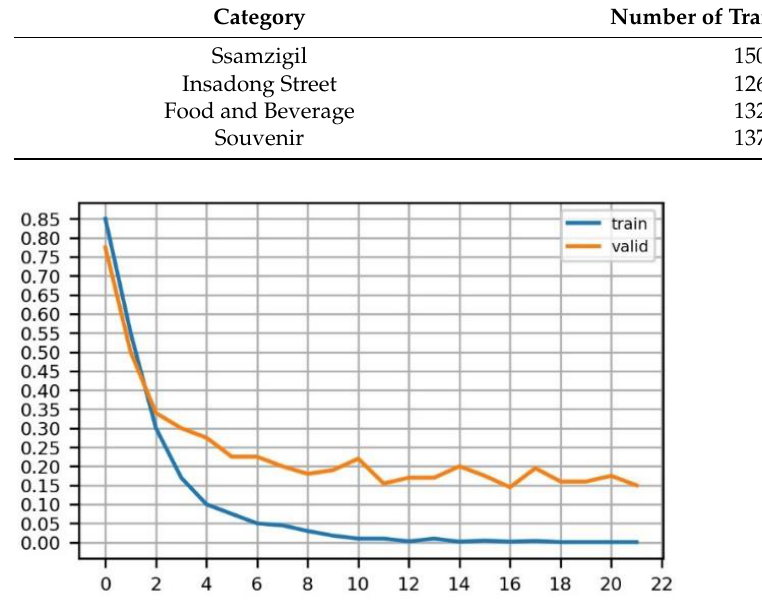
Figure 12. Loss graph of model training of Insadong.